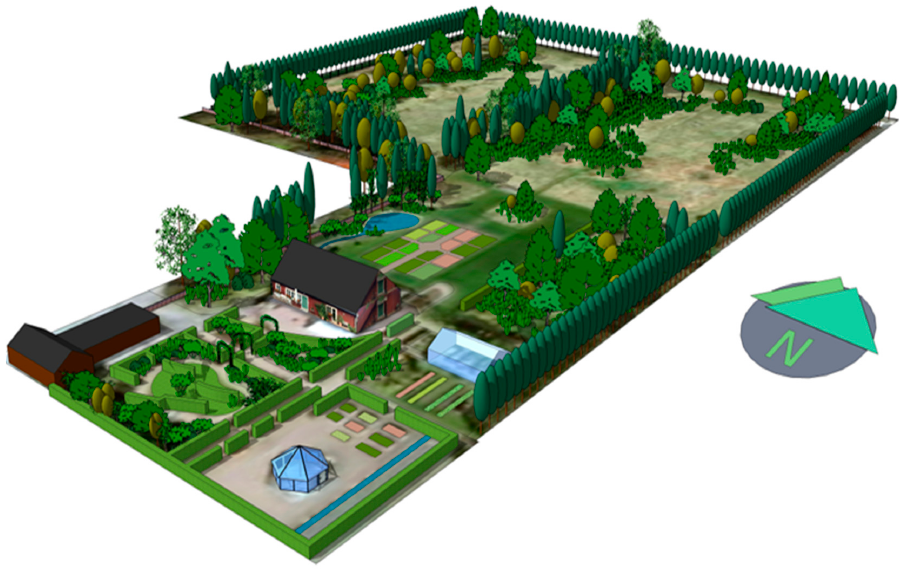
Figure 2. Alnarp Rehabilitation Garden, three-dimensional map made by Gunnar Cerwén.